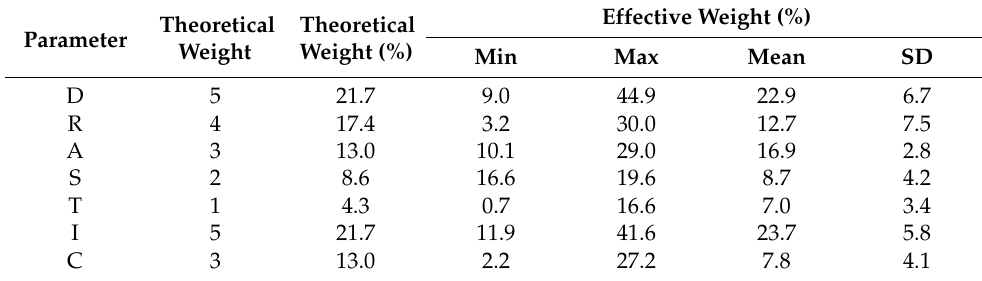
Table 3. Statistical summary of the single-parameter sensitivity analysis of DRASTIC.